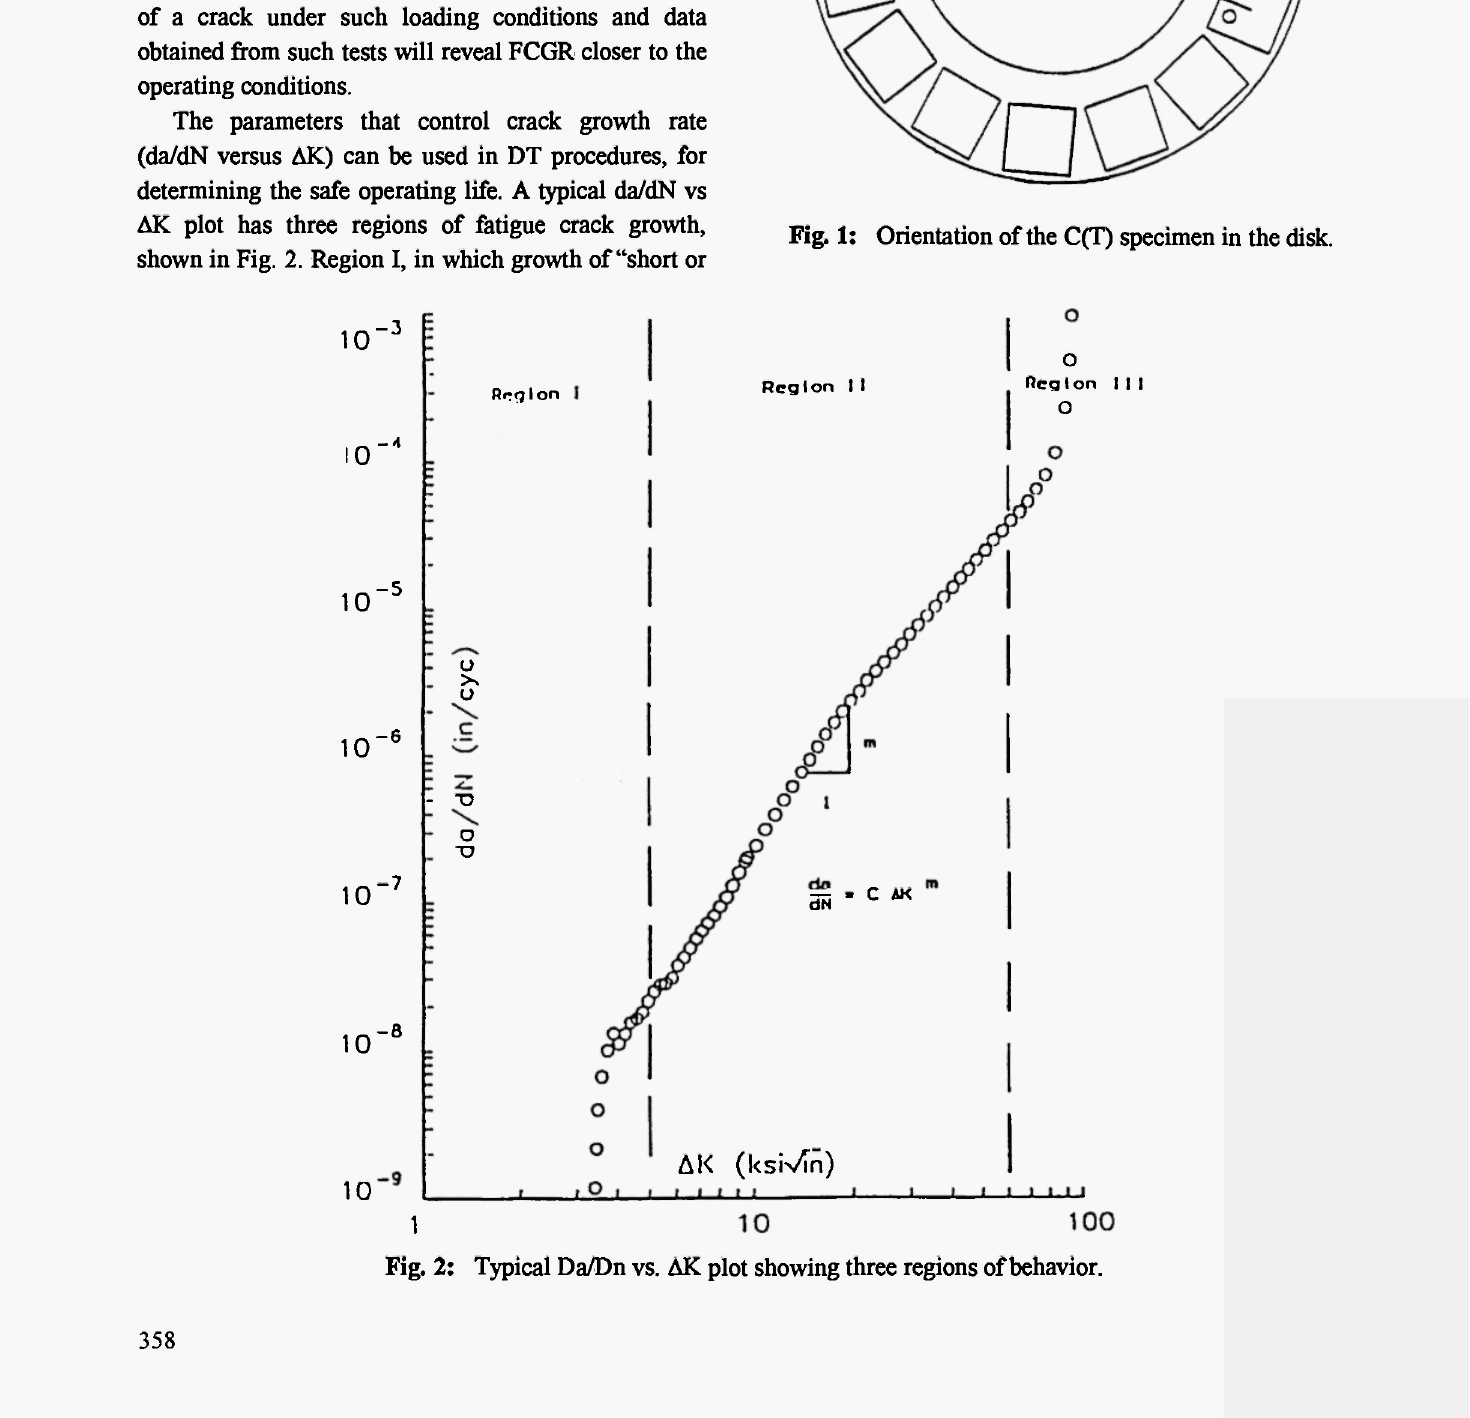
Fig. 1: Orientation of the C(T) specimen in the disk.